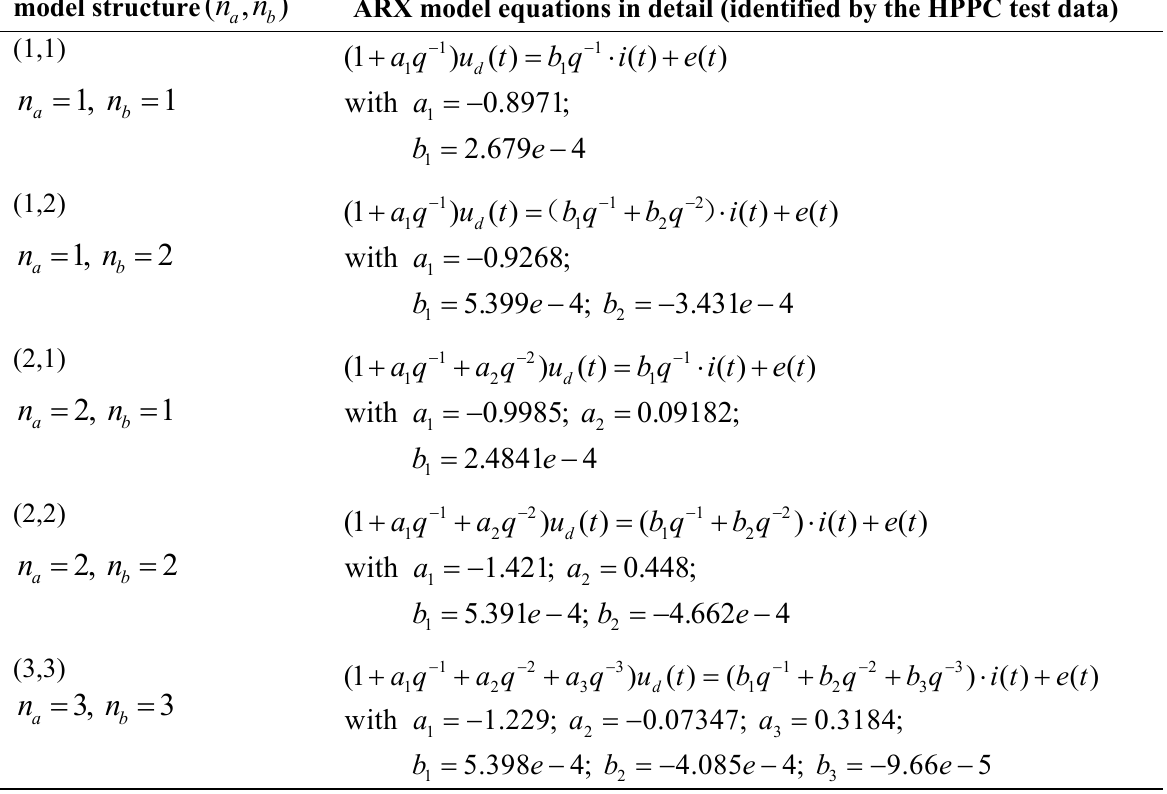
Table 3. List of the five ARX models and the identified results based on the HPPC test data. model structure ( ARX model equations in detail (identified by the HPPC test